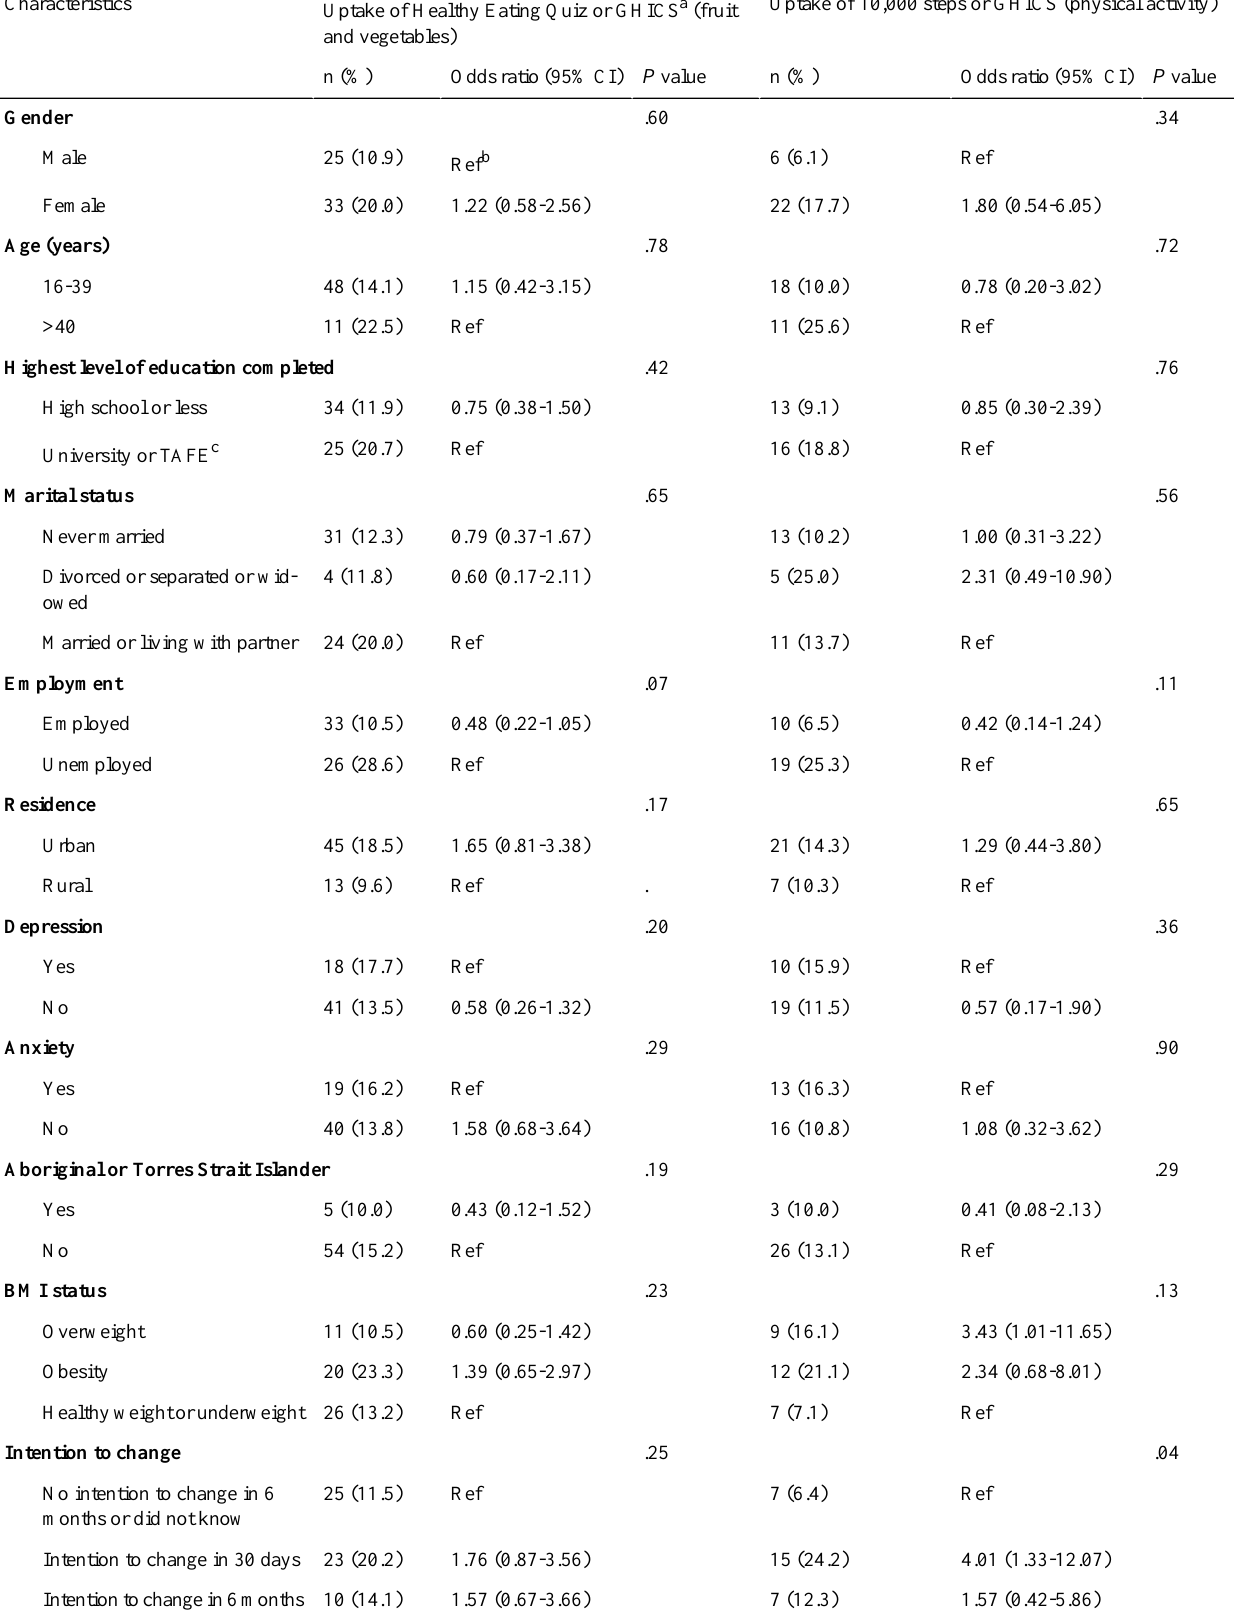
Table 5. Characteristics associated with the uptake of telephone or online support services for nutrition and physical